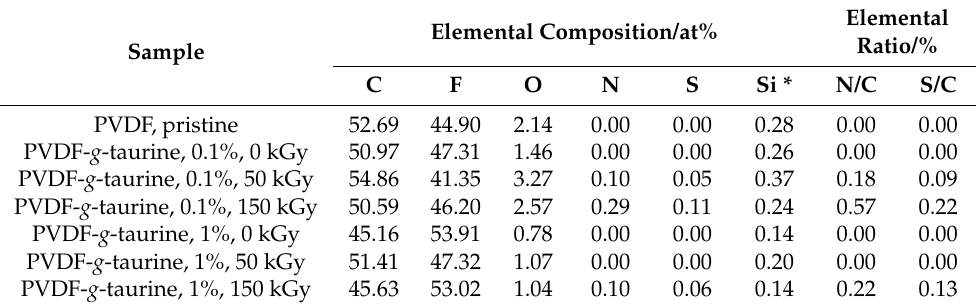
Table 2. XPS investigations of pristine PVDF membrane and PVDF modified with taurine (mass fractions ω = 0.1–1% and dosages of 0, 50, and 150 kGy). Elemental Sample